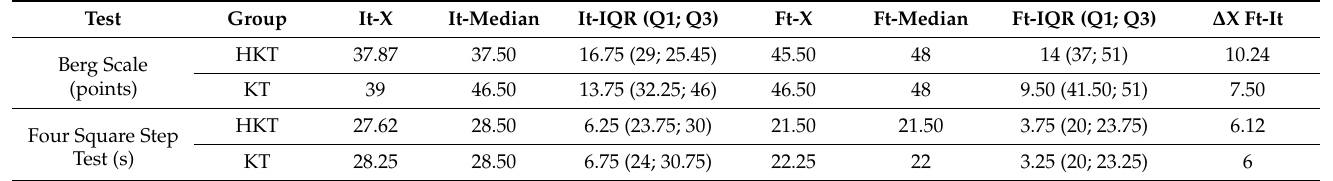
Table 3. Statistical analysis of the Berg Scale total score and four square step test